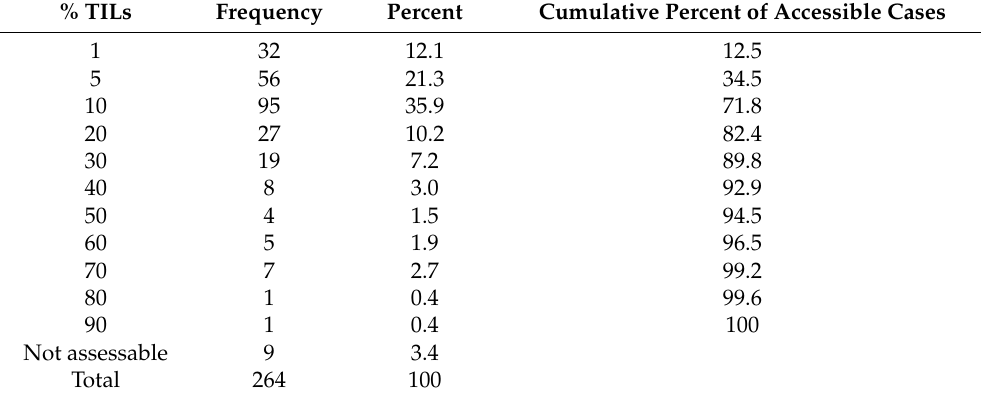
Table 1. TIL quantification according to the Salgado